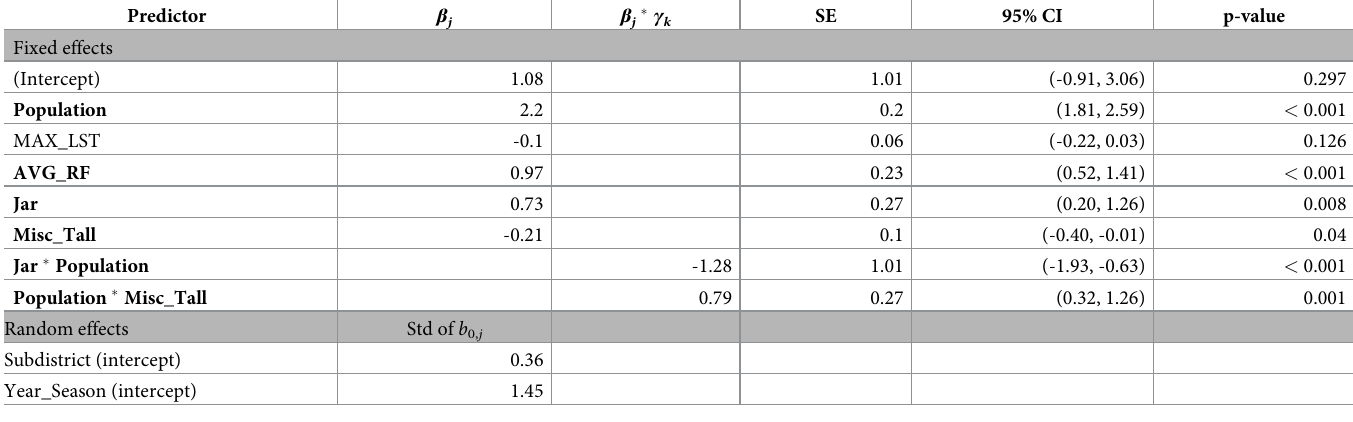
Table 5. The coefficients of the LMER+C model using training data (2015–2017) for Bangkok province. Significant variables with a p-value < 0.05 are indicated with boldface.